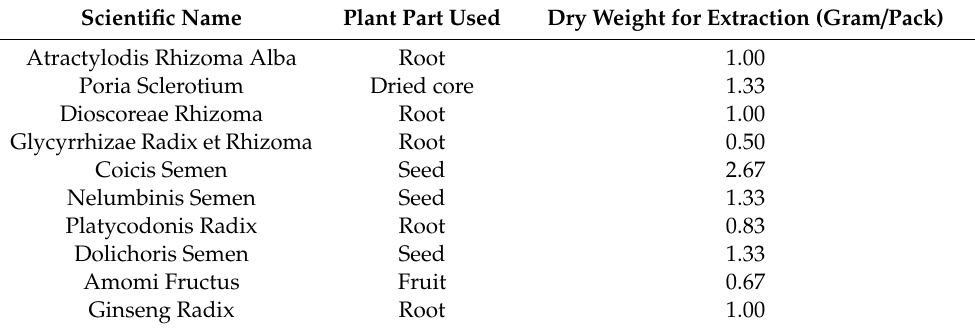
Table 2. Ingredients of the herbal formula